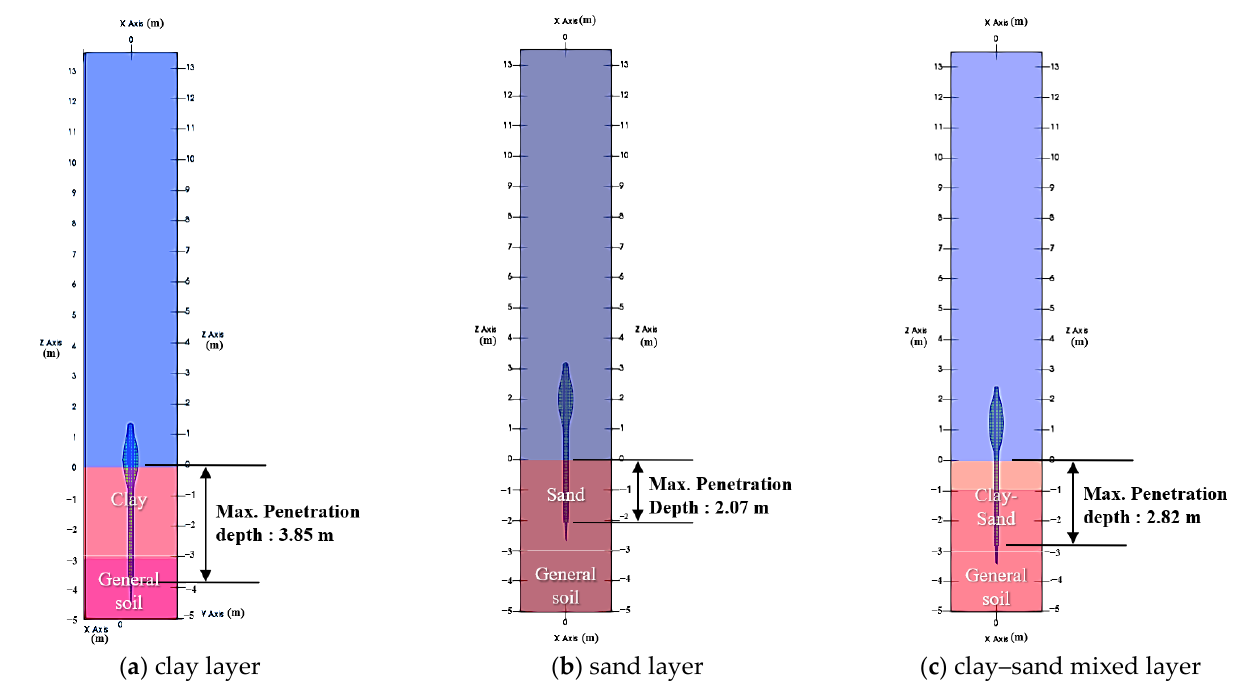
Figure 8. Maximum penetration depth of anchor pile (unit: m).